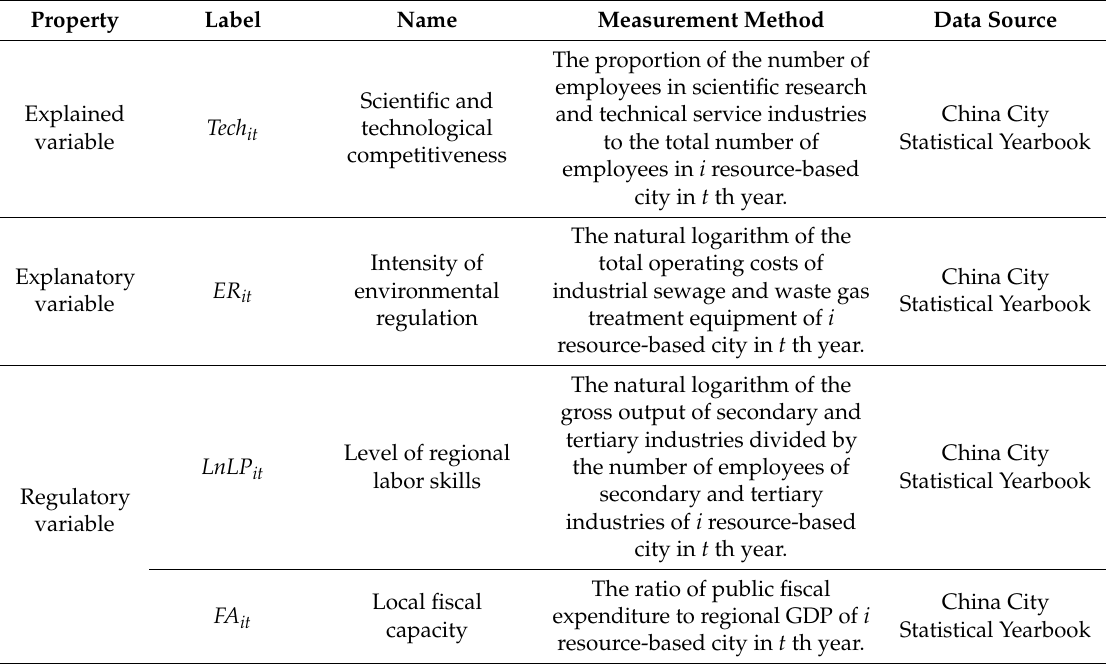
Table 1. Description of